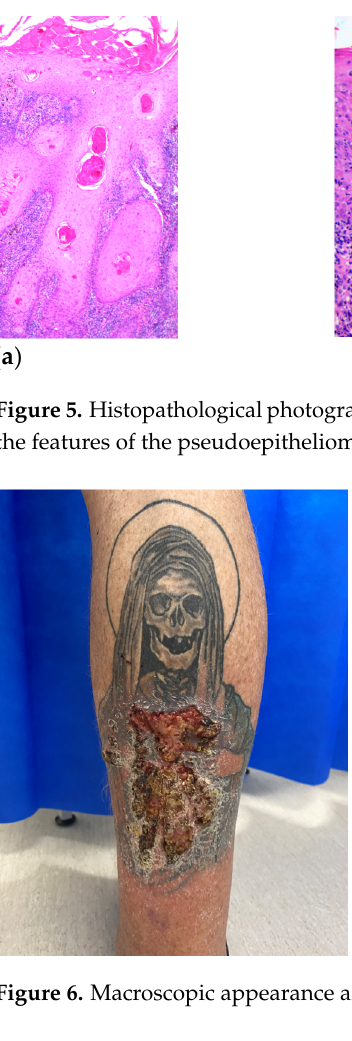
Figure 6. Macroscopic appearance after deep shave biopsy was performed.